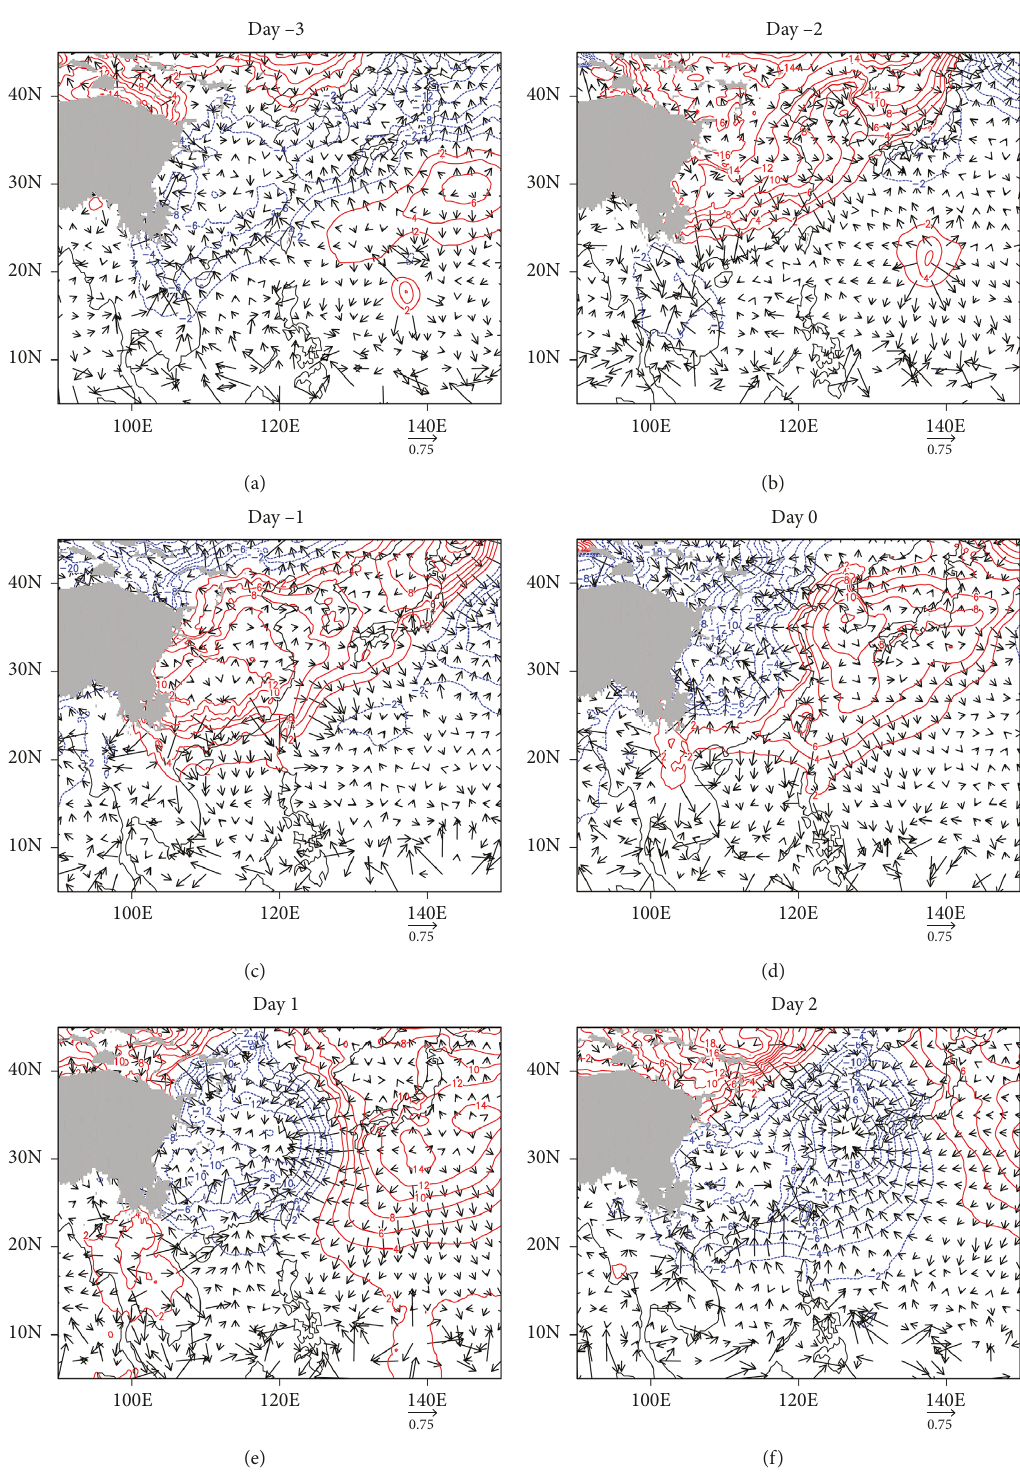
Figure 13: Same as Fig. 8, except for during the events associated with cold surge and upper-level